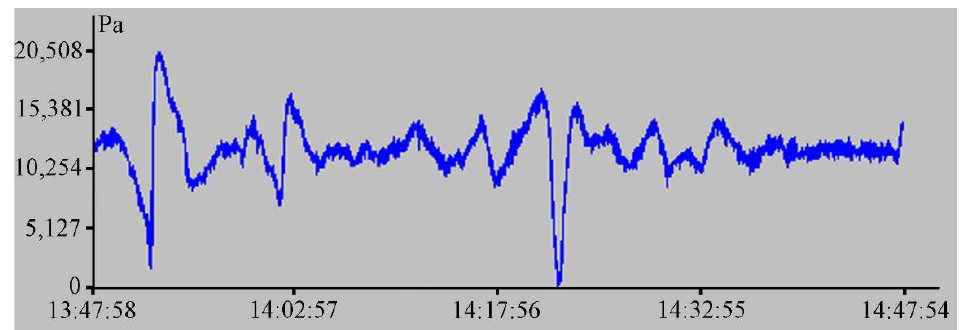
Figure 13. A recording section of the supersensitive detector of hydrosphere pressure variations for 1 June 2021 installed on the seabed at a depth of 27 m at Cape Shultz.